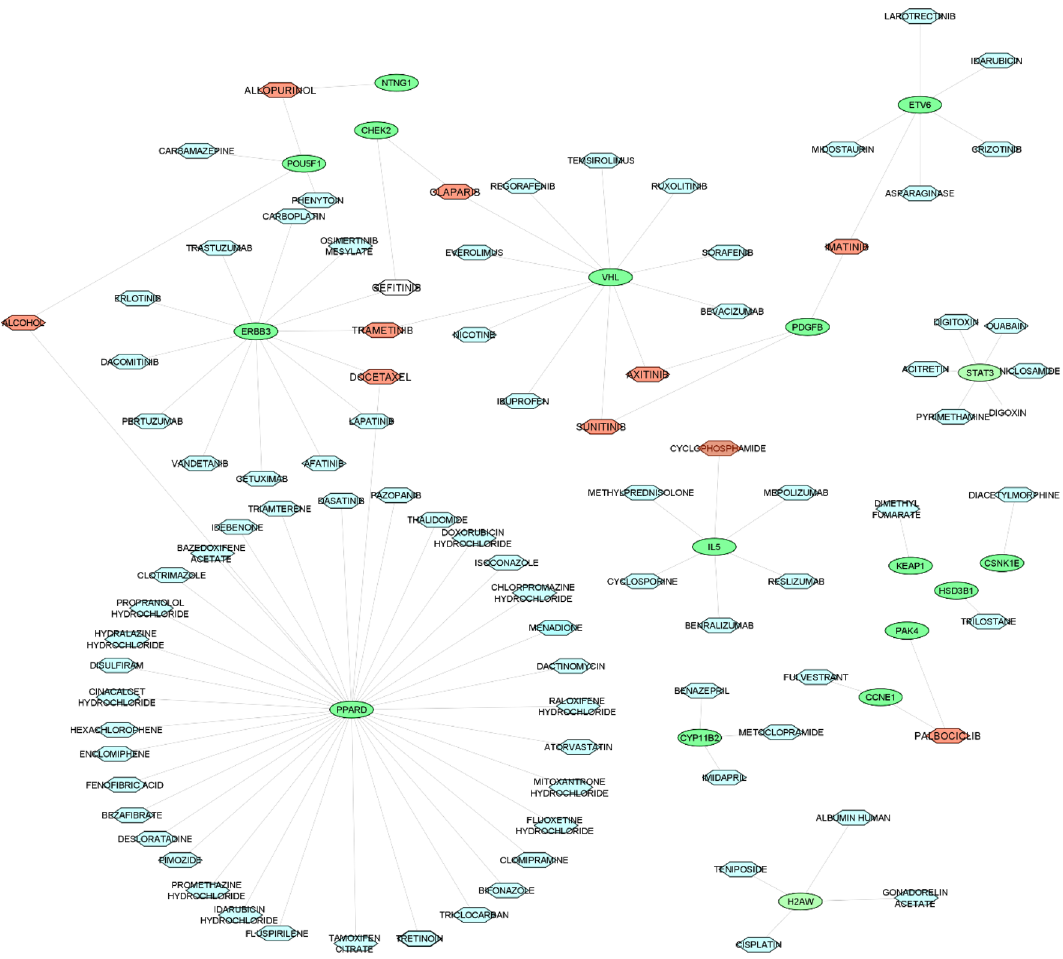
Figure 7. The candidate drug-gene network extracted from DGIdb database. The candidate drugs (lightblue hexagon) identified as regulators of the PBC-RNIT subnetwork. Among these drugs, some drugs can regulate more than two gene (red hexagon). Cytoscape v.3.8.2 was used to visualize the